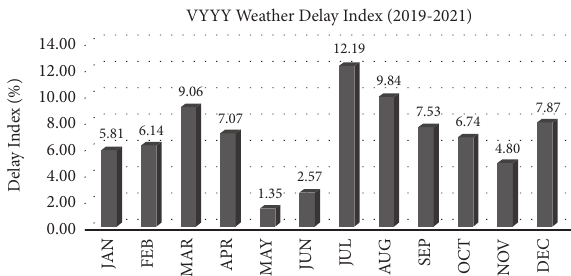
Figure 5: Weather delay index for VYYY (2019–2021).